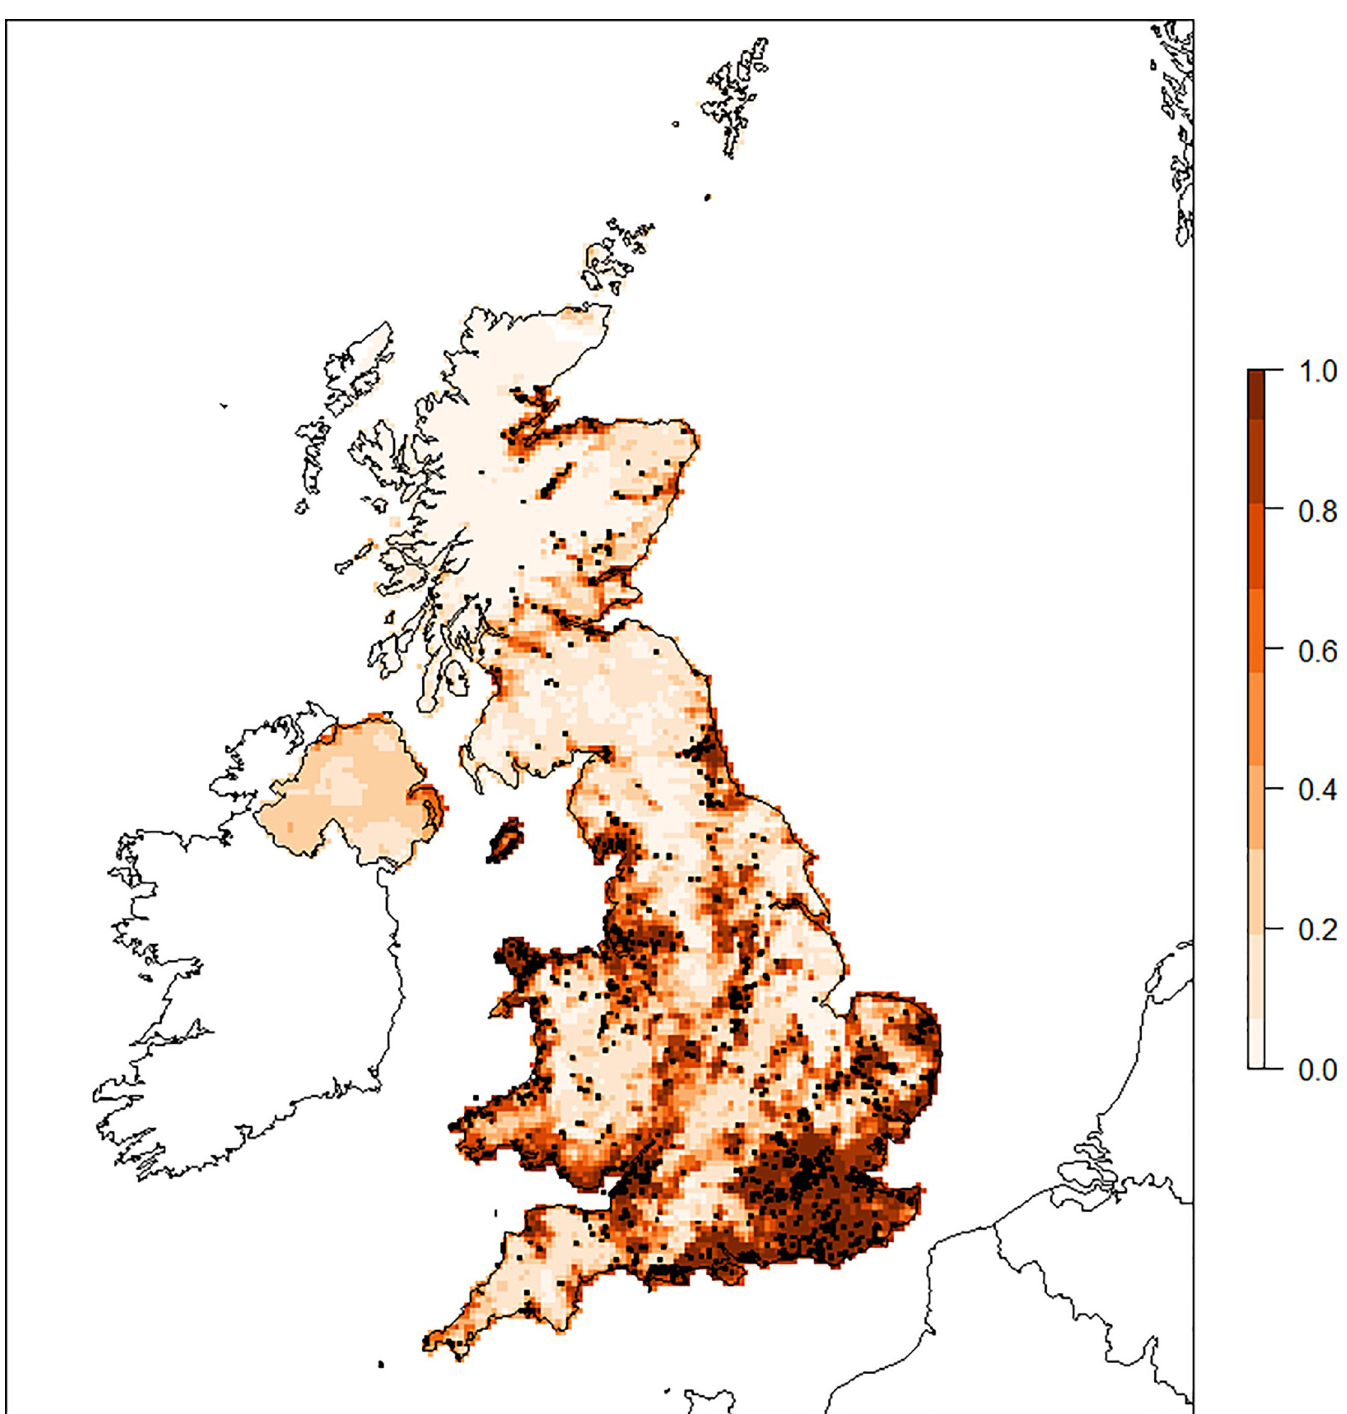
Fig 2. Consensus model map indicating probability of presence of RVF competent mosquito species. Higher values closer to 1 (darker shade) indicate higher relative probability of presence of competent mosquito species compared to lower values. Observed mosquito presence data are shown by the black squares.